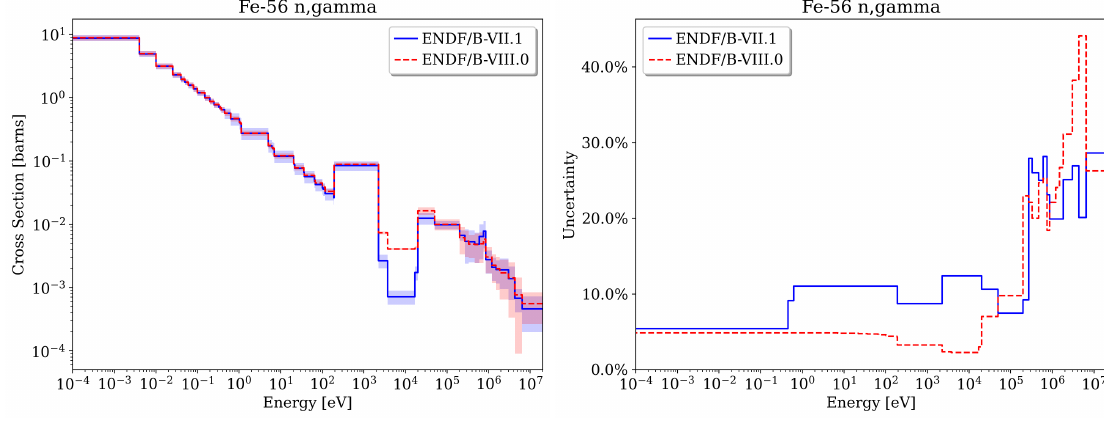
Figure A4. 56 Fe (n, γ ) nominal data and uncertainty.